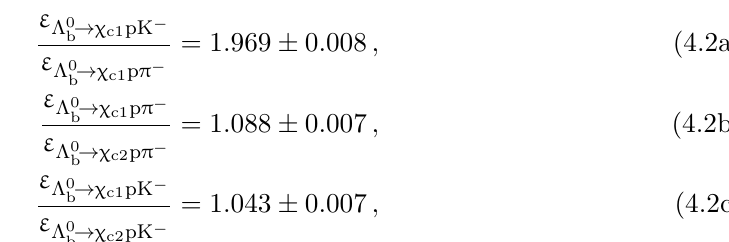
Figure 1 . Mass distribution for selected Λ 0 is